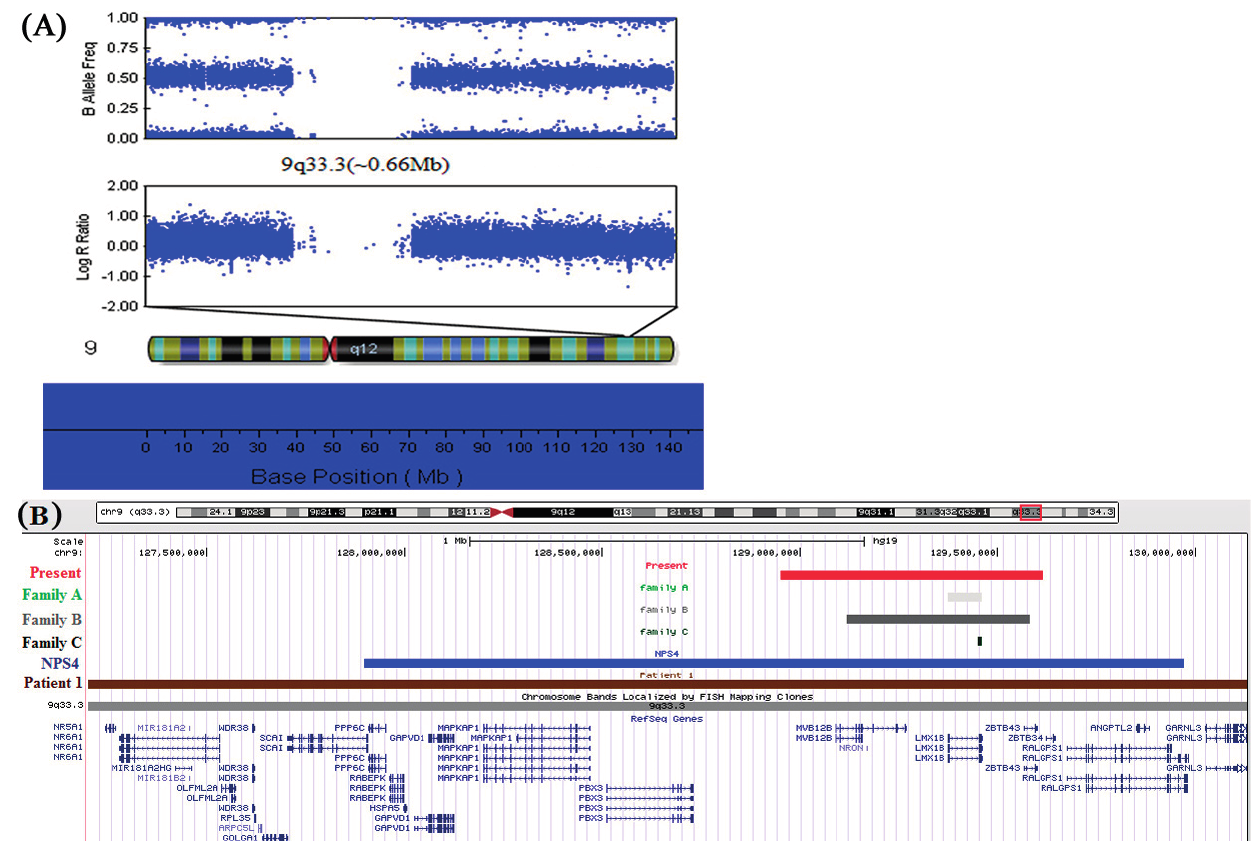
Figure 4. ( A ) The complete genome analysis of the proband. A 0.66 Mb deletion in chromosome band 9q33.3, between 128,952,700 and 129,613,085 bp, which was detected by using an Illumina genome-wide DNA analysis beadchip; ( B ) Enlargement of the 9q33.3–q34.11 region from the UCSC genome browser shows a comparison between the deleted segments, cytogenetics bands and RefSeq genes. Patient 1 from Schlaubitz et al. [32]: brown bar. Patients of families A, B, and C from Bongers et al. [25]: light gray to black bars. Patient NPS4 from Marini et al. [22]: blue bar. Patient in present study: red